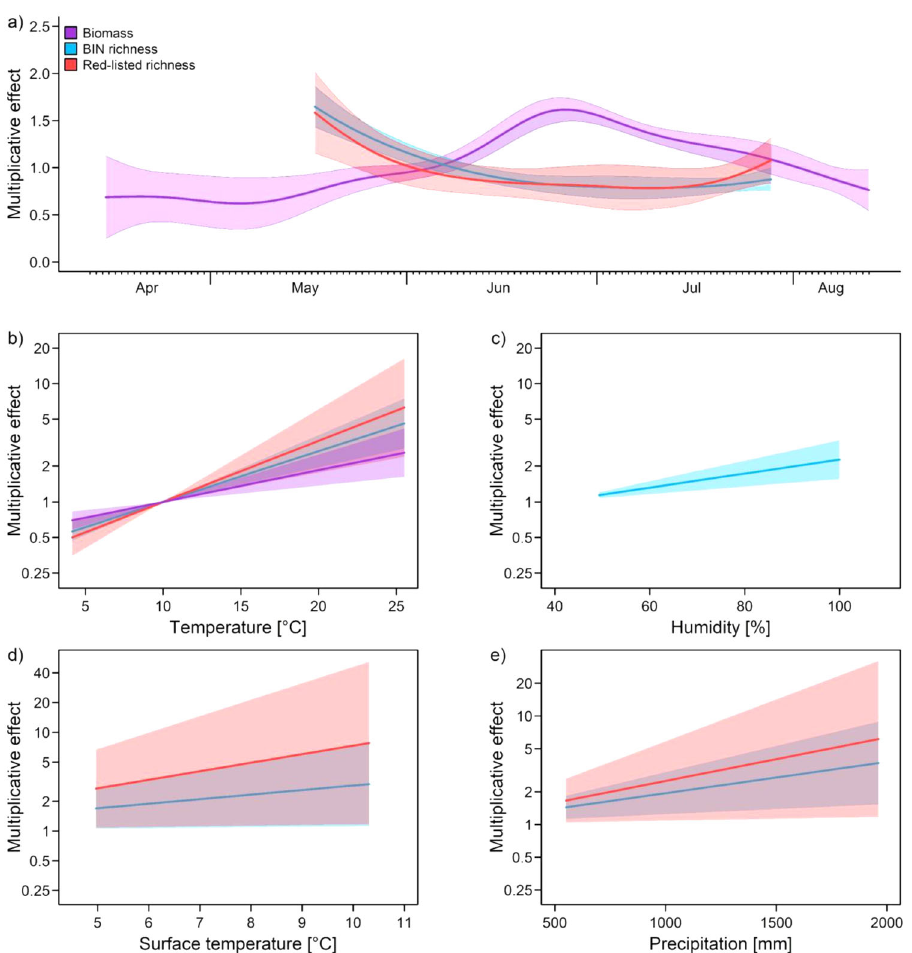
Fig. 2 Partial effects of season and climate parameters on biomass, total BIN richness and richness of red-listed species. Partial effects of ( a ) season, ( b ) local temperature, ( c ) humidity (both data logger), ( d ) long-term mean annual near-surface temperature (1991 – 2020), and ( e ) long-term mean annual precipitation (1991 – 2020) on biomass, total richness of barcode index numbers (BINs), and the richness of red-listed species collected with Malaise traps in 179 plots. Partial effects from generalized additive mixed models (for details, see Table 1) were controlled for elevation, the geographic location of the traps, and land use (for the latter, see Fig. 3). Note that richness was determined for only three of the eight sampling campaigns. (a) partial effect of season, as a smooth term acting multiplicatively on the expected outcome per time unit. Multiplicative effects for local temperature and humidity were estimated using baselines of 10 °C and 40%, respectively. Error envelopes depict standard errors below and above the estimated mean